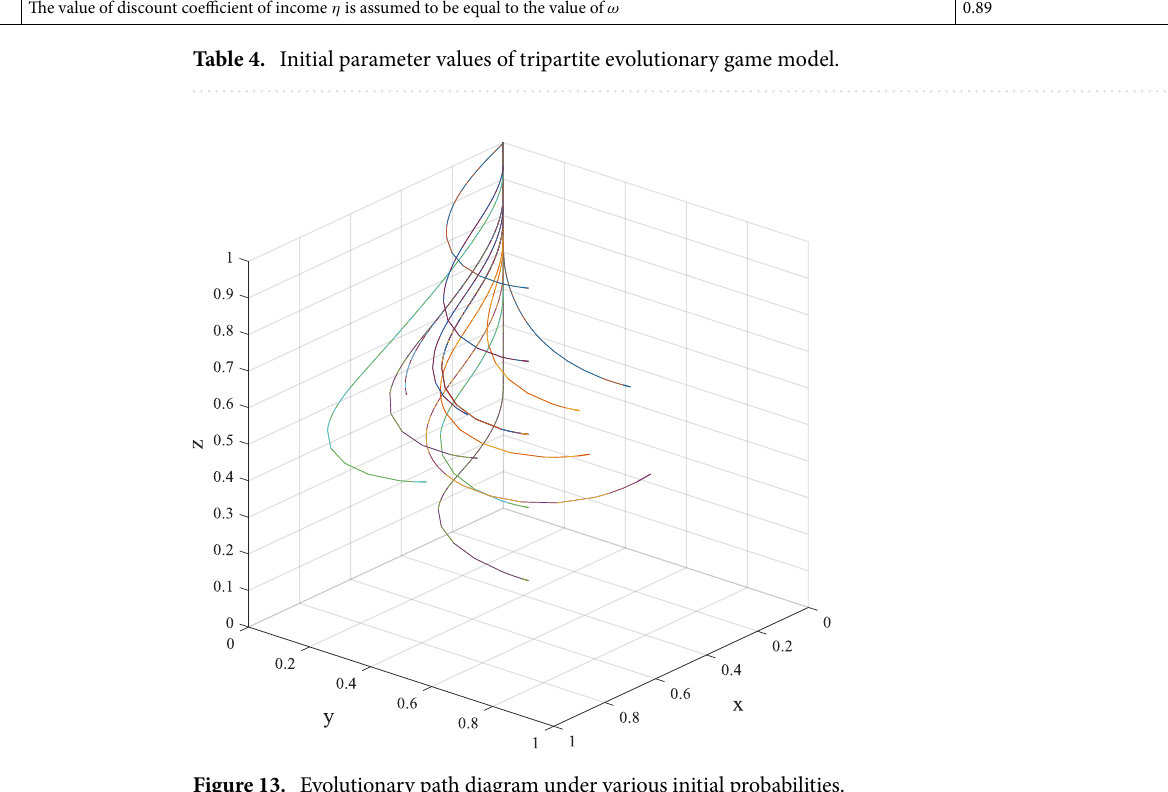
Figure 13. Evolutionary path diagram under various initial